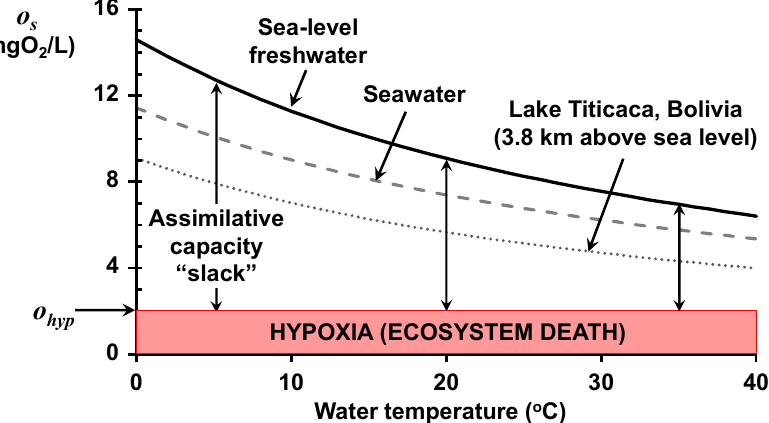
Figure 1. Dissolved oxygen saturation (mgO 2 /L) versus temperature ( ◦ C) for sea-level freshwater, seawater, and a very high-elevation freshwater lake. The vertical arrows specify the difference between the saturation concentration and an oxygen concentration standard corresponding to hypoxia. This is termed assimilative capacity “slack”; that is, the maximum allowable dissolved oxygen deficit that can be generated before hypoxia occurs. The plot indicates how the saturation and the assimilative capacity “slack” of all three systems decrease with rising water temperature.